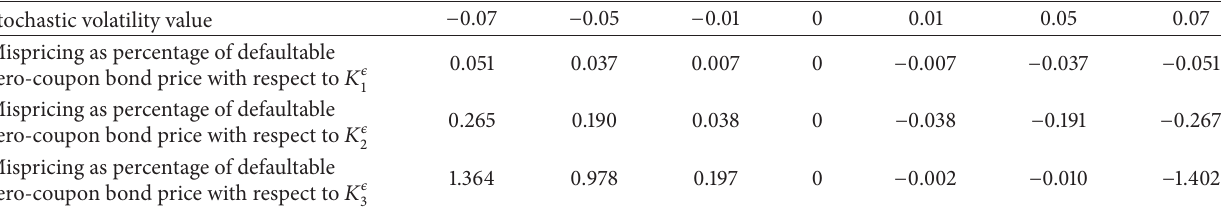
Table 1: Effect of stochastic volatility terms.